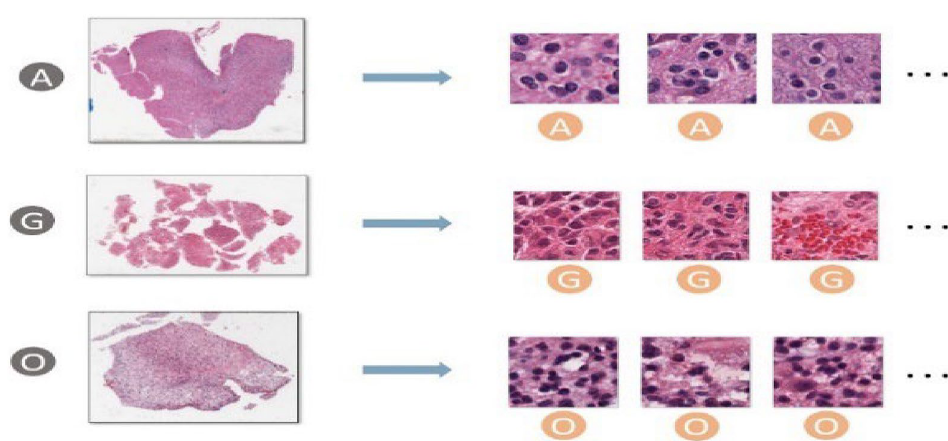
Figure 2. Patch sampling: Patches are randomly sampled from the densely cell-distributed areas of a WSI. All sampled patches have the same category as the label of the corresponding